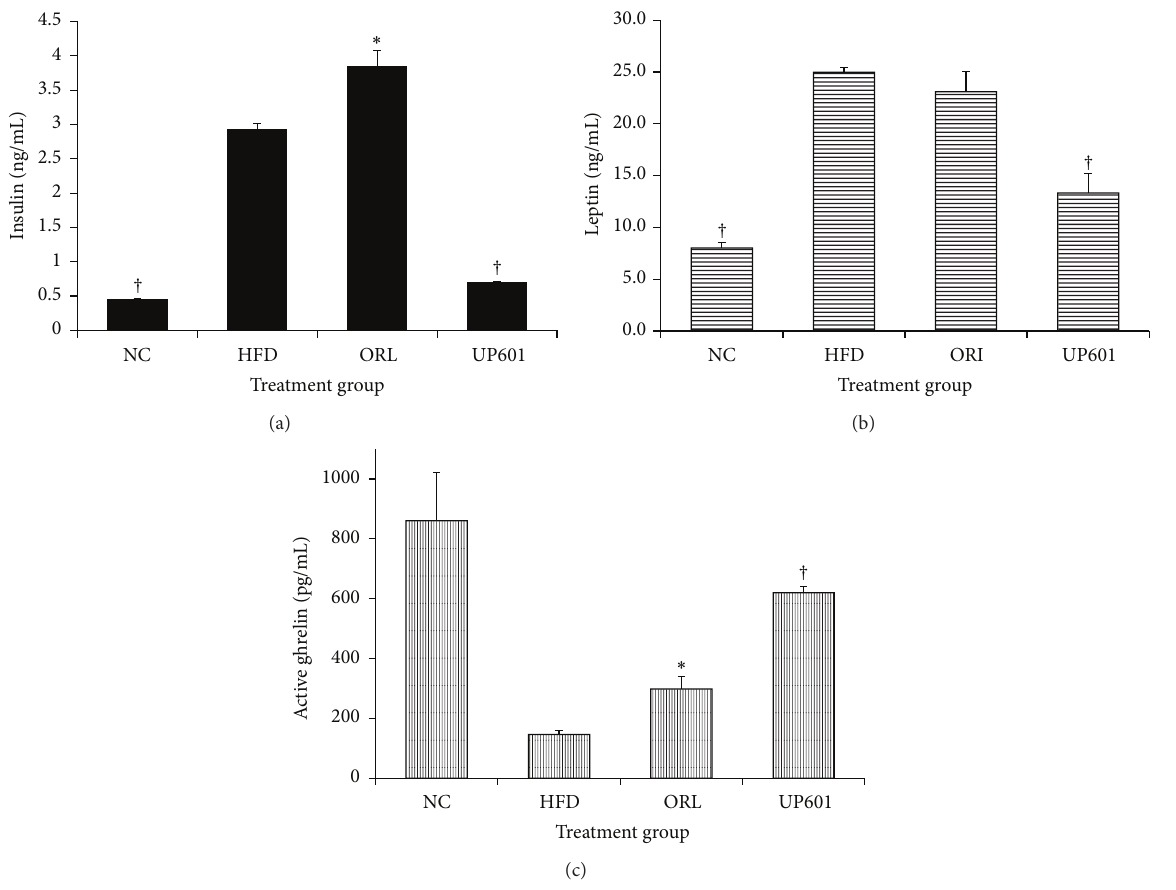
Figure 9: Insulin (a), leptin (b), and ghrelin level (c) of obese mice treated with UP601 at oral doses of 1.3g/kg for 7 weeks. † 𝑃 ≤ 0.0001 ; ∗ 𝑃 ≤ 0.05 .